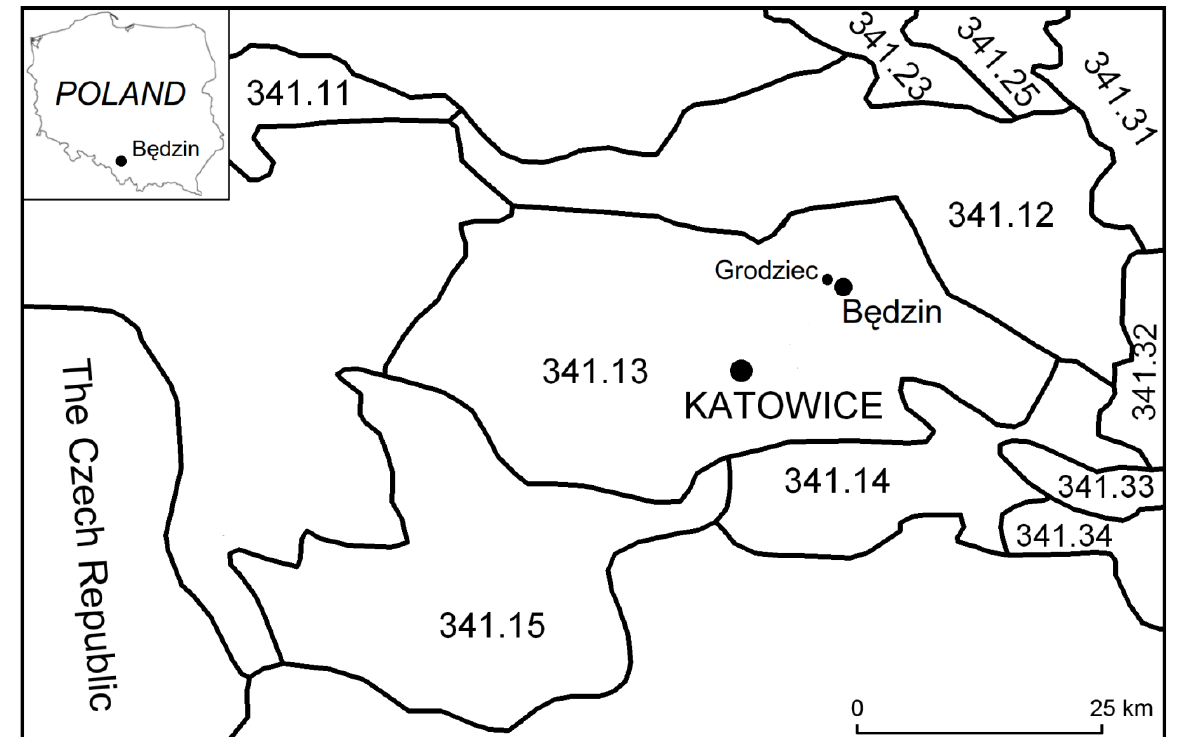
Fig. 1. Location of Grodziec on the background of the geographical regionalization of Poland by Kondracki (2000) 341.11 – Chełm, 341.12 – Tarnowskie Góry Hummock, 341.13 – Katowice Upland, 341.14 – Jaworzno Hills, 341.15 – Rybnik Plateau, 341.23 – Woźniki Ledge, 341.25 – The Valley of Upper Warta, 341. 31 – Częstochowa Upland, 341.32 – Olkusz Upland, 341.33 – Krzeszowice Trench, 341.34 – Tenczyn